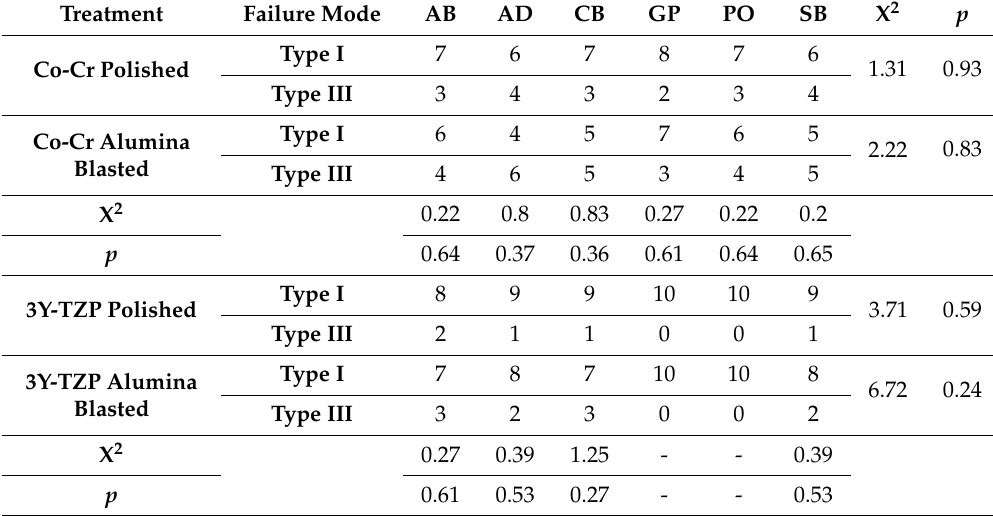
Figure 5. Representative stereomicroscopic images of Co-Cr alloy ( top ) and 3Y-TZP (bottom ) surfaces after debonding, demonstrating type I (adhesive) and type III (adhesive and resin cohesive) failures with various extent of surface coverage (10× magnification, bar = 1 mm). Table 5. The results of the failure mode analysis.